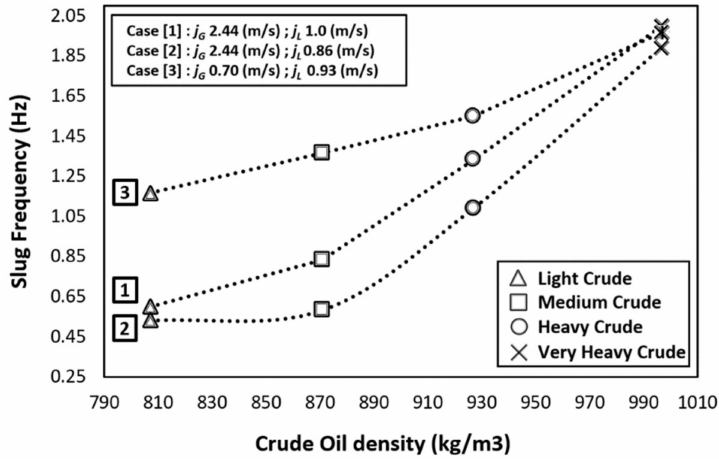
Figure 14. Effect of varying crude oil grades on slug frequency. The slug frequency increases when the crude oil density increases. Moreover, as the density of crude oil increases, the difference in slug frequency values decreases at different fluid and gas velocities. For instance, the slug frequency for very heavy crude oil fluctuates between 1.89 and 2 Hz for all examined superficial